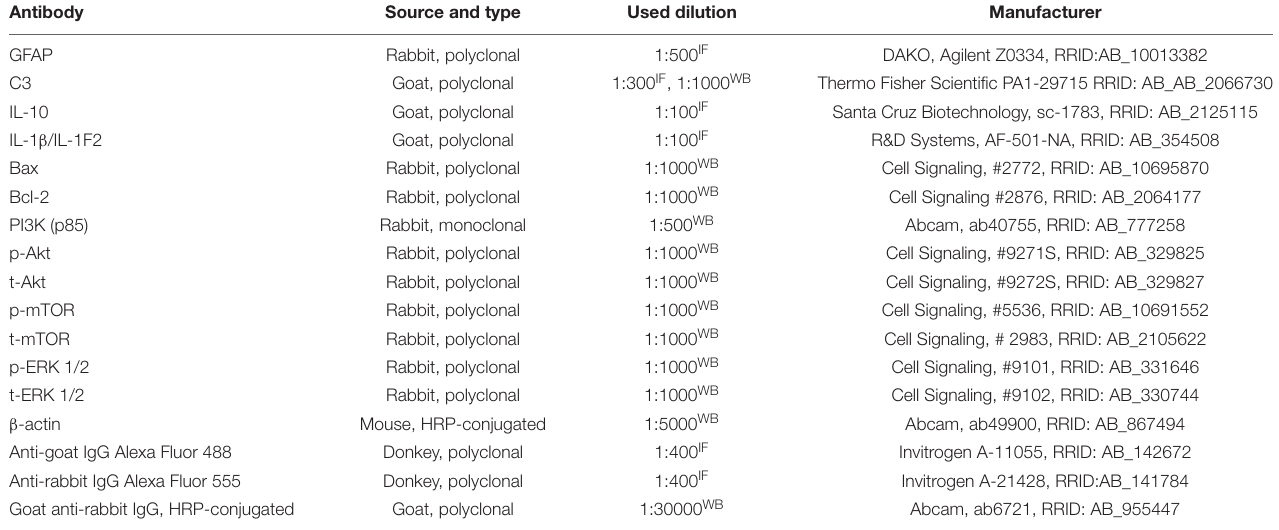
TABLE 1 | List of used primary and secondary antibodies. Antibody Source and type Used